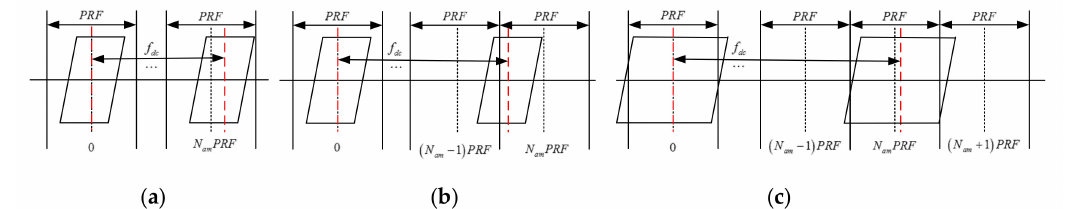
Figure 2. Target spectrum along azimuth. ( a ) Case 1: Target spectrum is entirely in one pulse repetition frequency (PRF) band. ( b ) Case 2: Target spectrum occupies two neighboring PRF bands. ( c ) Case 3: Target spectrum spans over several PRF